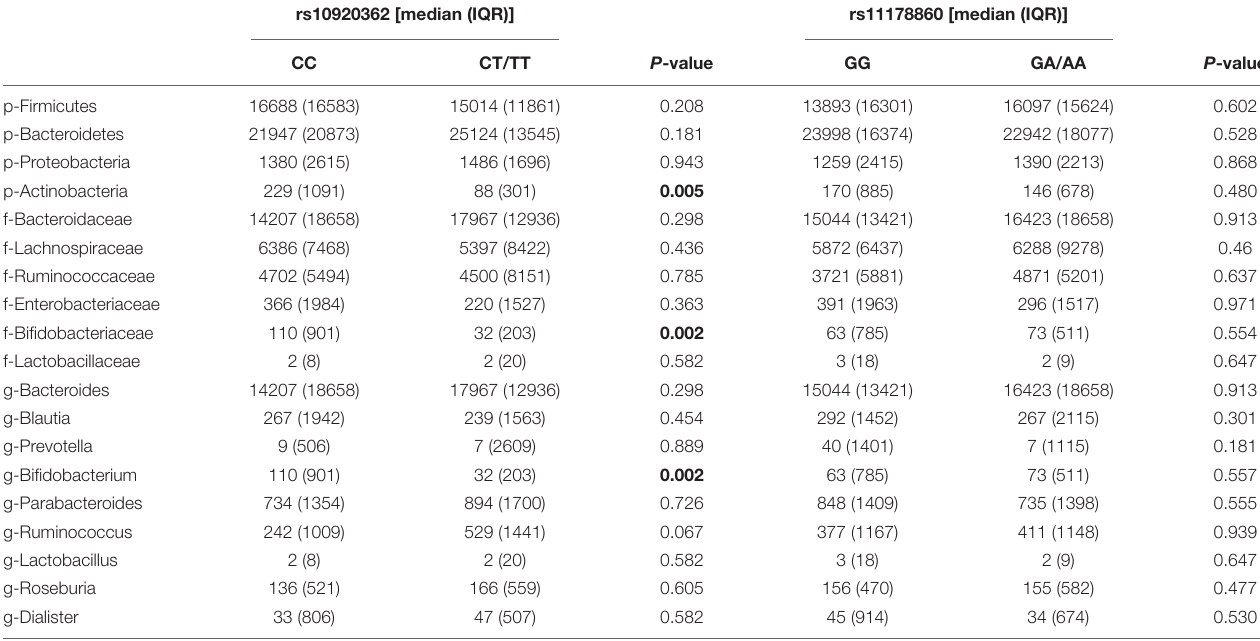
TABLE 4 | Comparisons of gut microbiota composition stratified by the rs10920362 and rs11178860